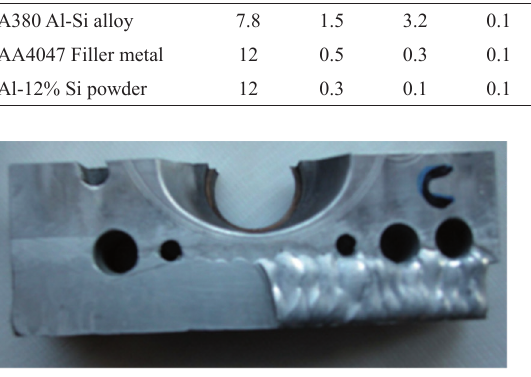
Figure 2: Macrograph of a sample repaired through TIG welding.